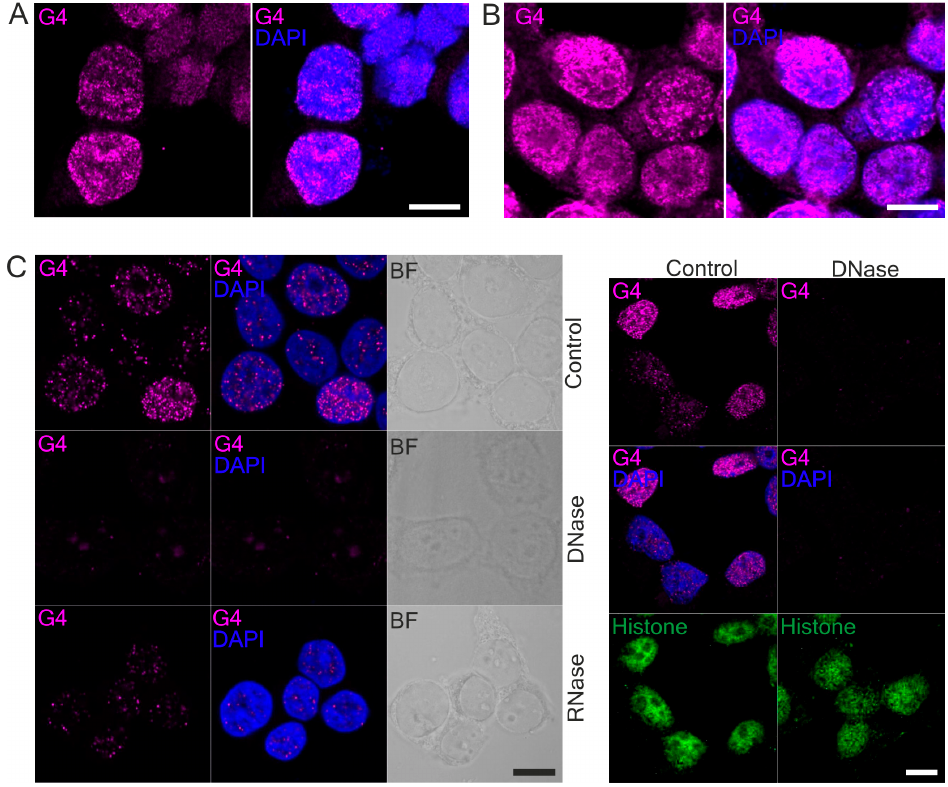
Figure 4. G4 immunolabelling in HEK293T cells. ( A ) Mouse and ( B ) goat 1H6 antibodies were used to visualize the G4 structures (magenta). ( C ) G4-specific staining (mouse antibodies) disappeared after the treatment with DNase but were still visible after the treatment with RNase. Cells were fixed in methanol. Nuclei were counterstained with DAPI (blue) or histone H3 (green), where transmission bright-field (BF) images show the cell morphologies. Scale bars: 10 μ m.